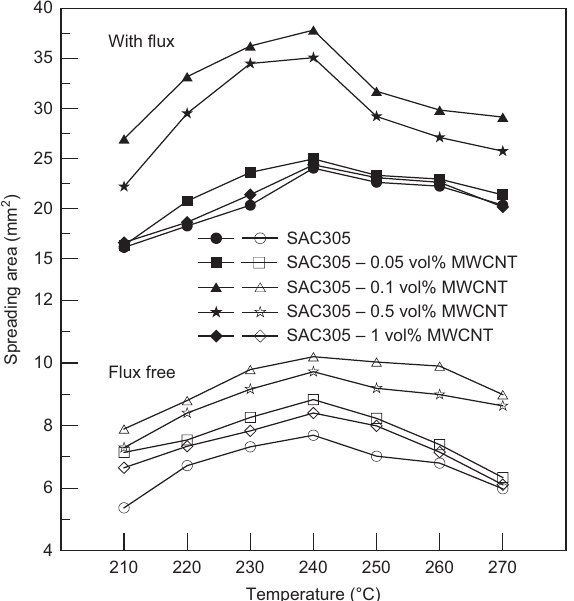
Figure 3 Spreading area as a function of temperature for MWCNT- reinforced composite solders on copper substrate.